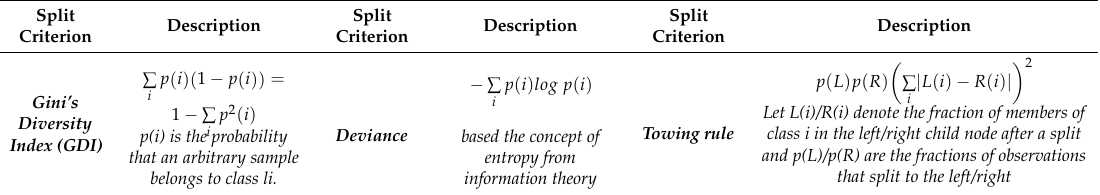
Table A1. The common techniques for splitting nodes in